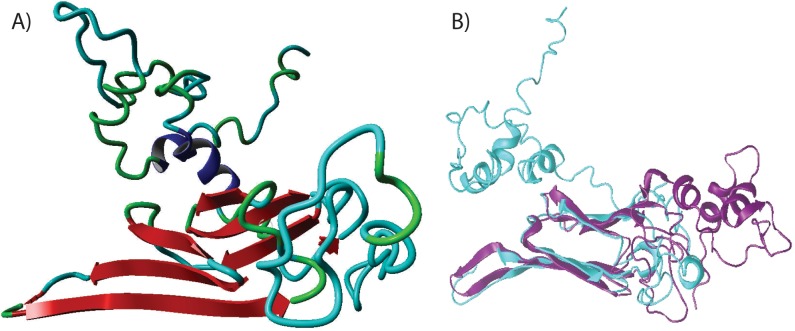
Modeled 3D structures.(A) The 3D structure of Arabian Camel HSPB-1 protein. (B) Stereo ribbon representation of the predicted 3D structure model of Arabian camel HSPB-1 (cyan) and the superimposition with Homo sapiens
α-B-crystallin chain V (purple).